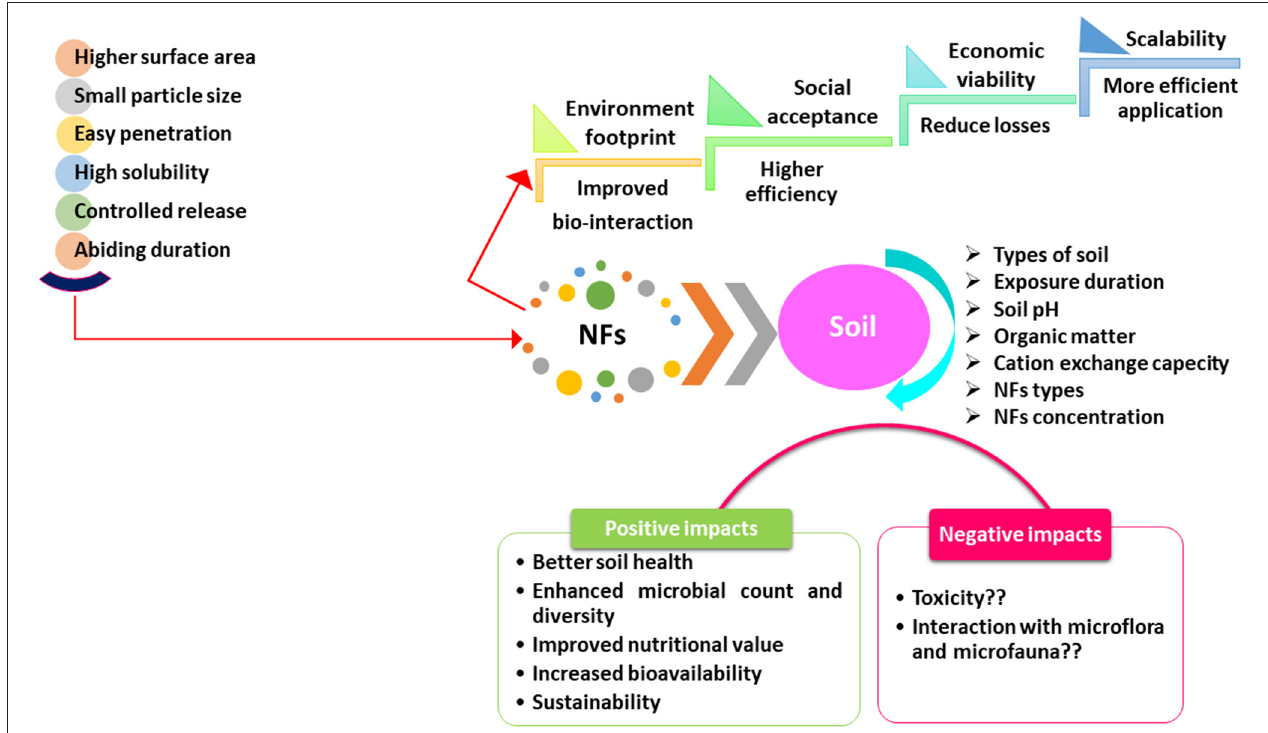
FIGURE 1 | An overview of the role of nanofertilizers in